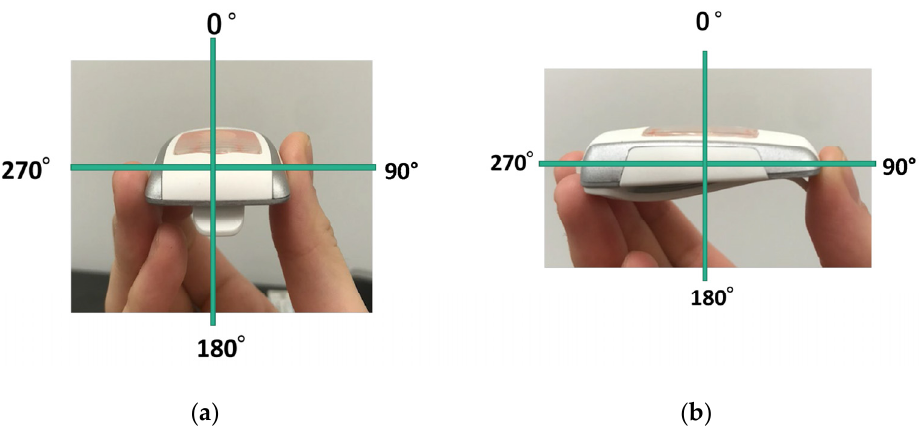
Figure 4. Experimental layout for evaluation of angle dependency: ( a ) Horizontal; ( b ) Vertical.